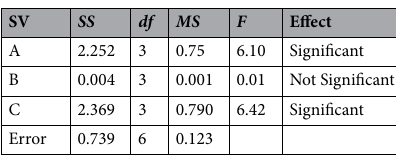
Table 7. The variance analysis of total pore volume. F 0.01 (3, 6) = 9.78; F 0.05 (3, 6) = 4.76; F 0.1 (3, 6) =